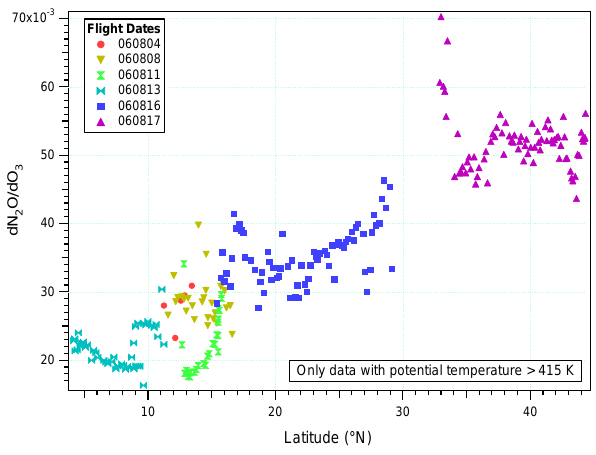
Fig. 10. Slope dN 2 O/dO 3 against latitude for the AMMA/SCOUT- O3 flights.